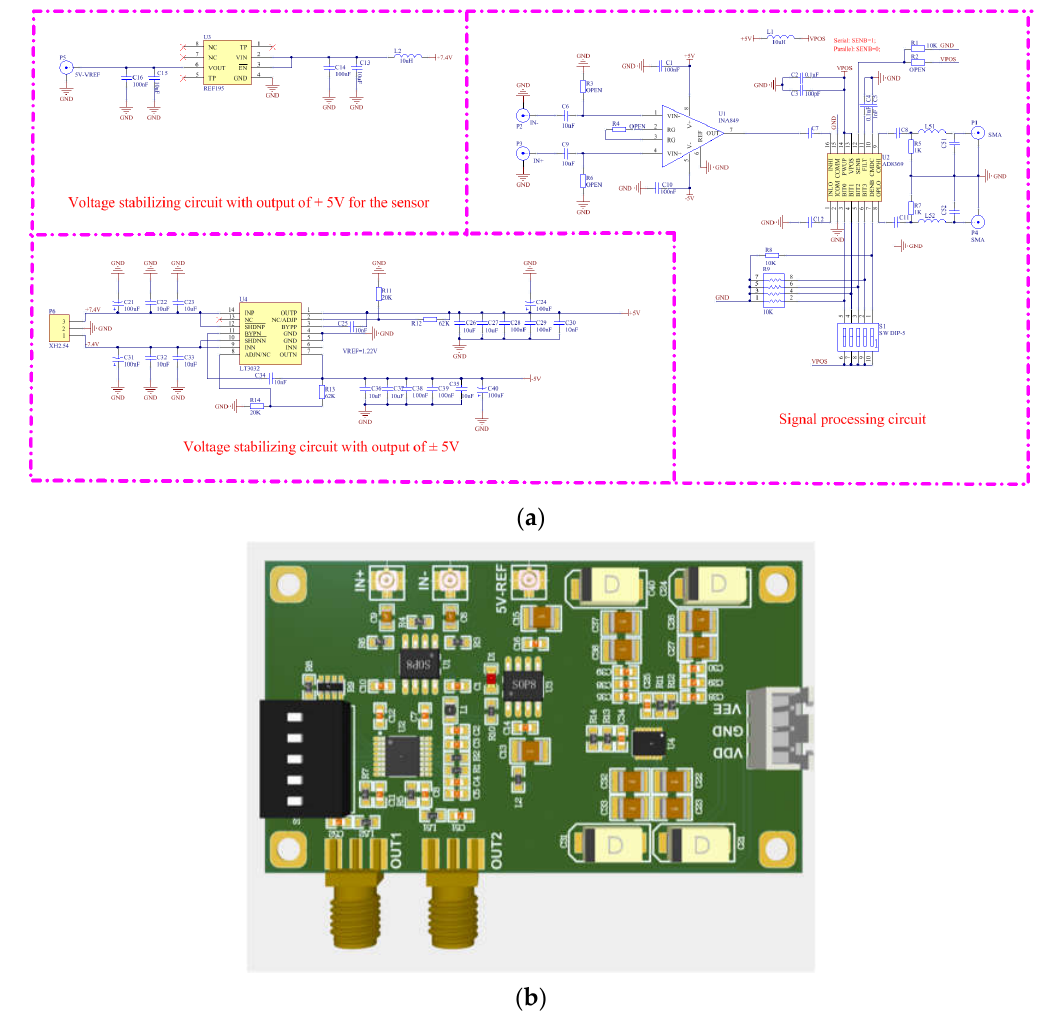
Figure 5. ( a ) Circuit schematic, ( b ) top view of the PCBA of the proposed hardware circuit.